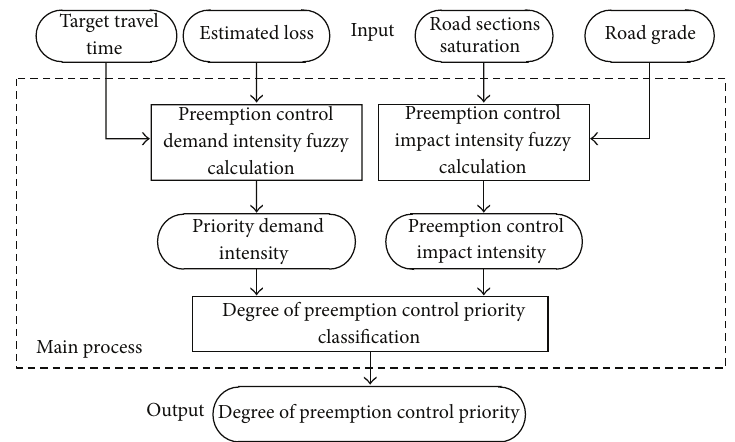
Figure 2: Emergency vehicle preemption signal control priority classification